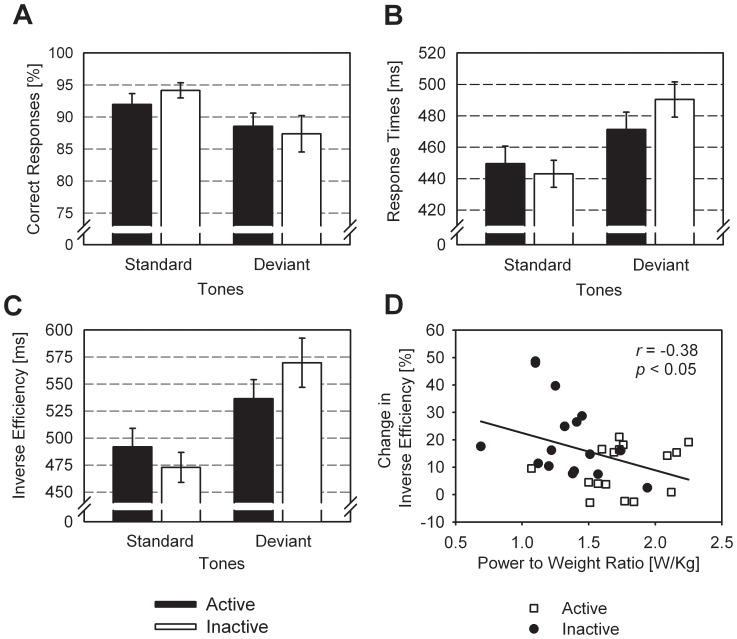
Rates of correct responses (A), response times (B), and inverse efficiency scores (C) for physically active and inactive participants, shown separately for the frequent standard tones and the rare deviant tones.Error bars indicate standard errors across participants (N = 16). (D) Percentage change in inverse efficiency scores (deviant tones relative to standard tones) as function of physical fitness (power to weight ratios) for each participants (N = 32), shown separately for active and inactive participants with linear regression line.